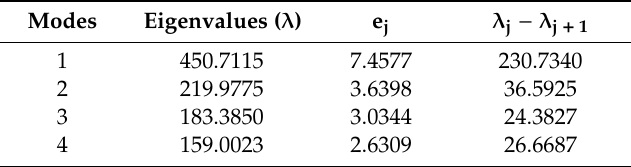
Table 1. The information about the eigenvalue error